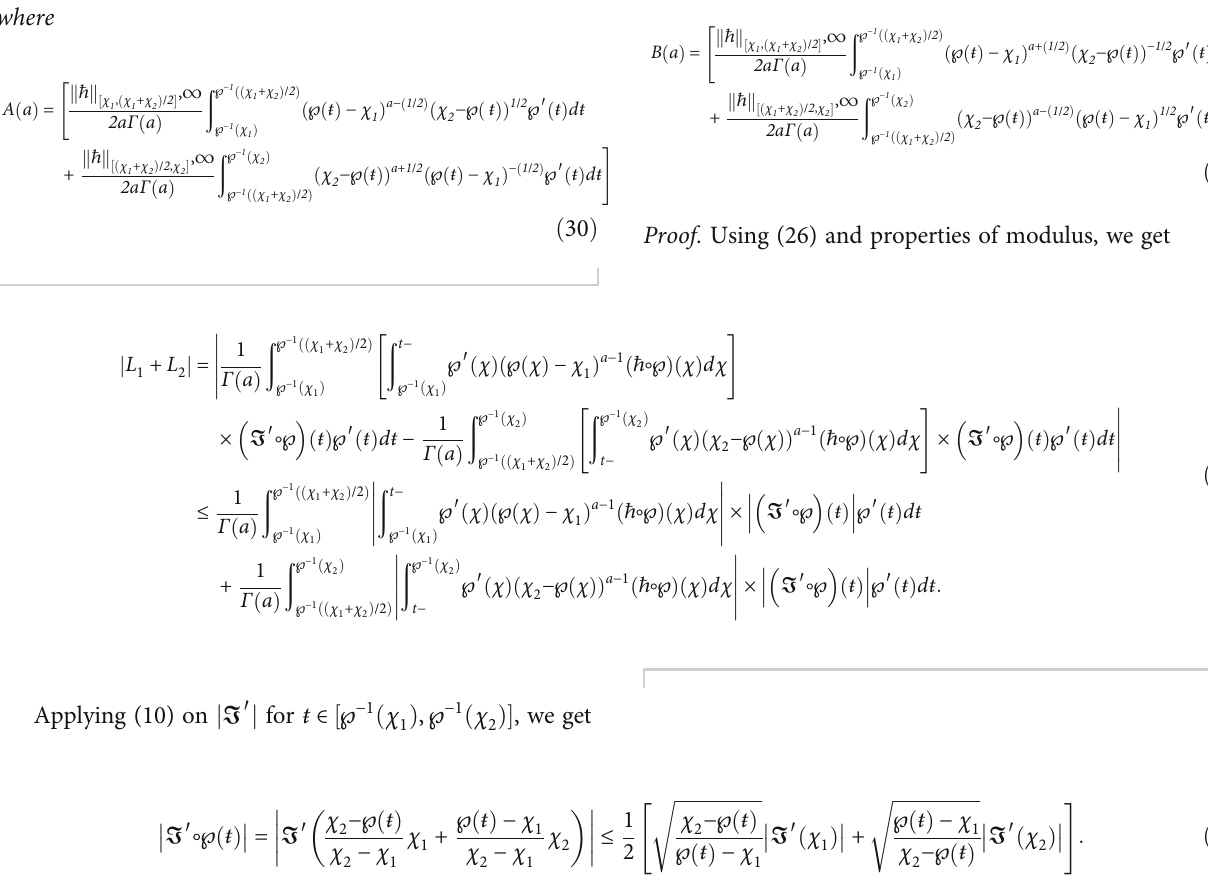
ffiffiffiffiffiffiffiffiffiffiffiffiffiffiffiffiffiffi χ − ℘ ŧ ð Þ 2